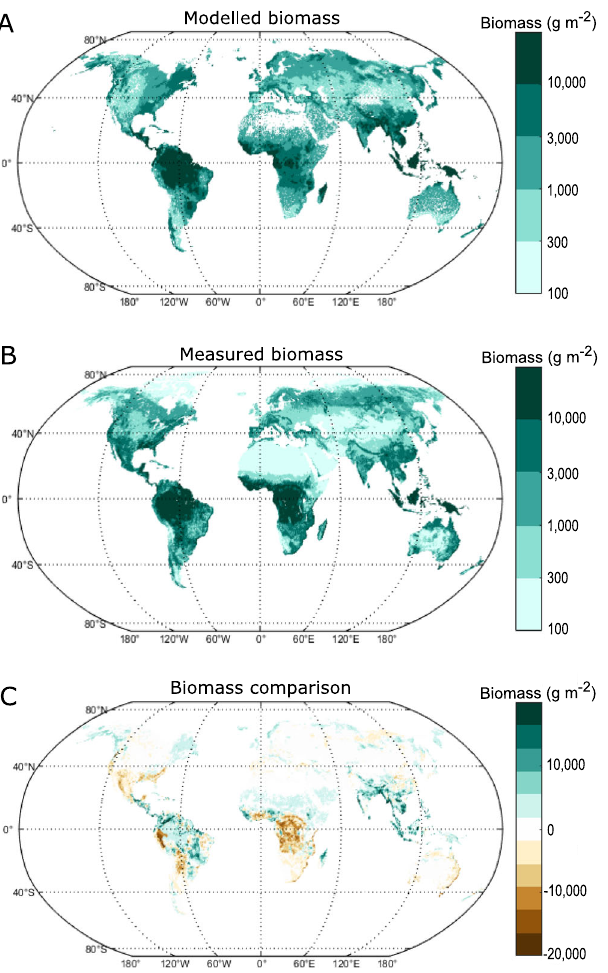
Fig. 3 | Modelled and measured biomass comparison. The model predicts a reasonable approximation of current biomass. A Model predicted biomass given average temperatures (between 1900 – 1990) and ‘ best estimation ’ of yearly runoff fromtheyear2000. B Actualabove-andbelow-groundglobalbiomassfortheyear 2000 obtained from CDIAC 35 . C Areas of over-prediction (green) and under- prediction (brown) of biomass.